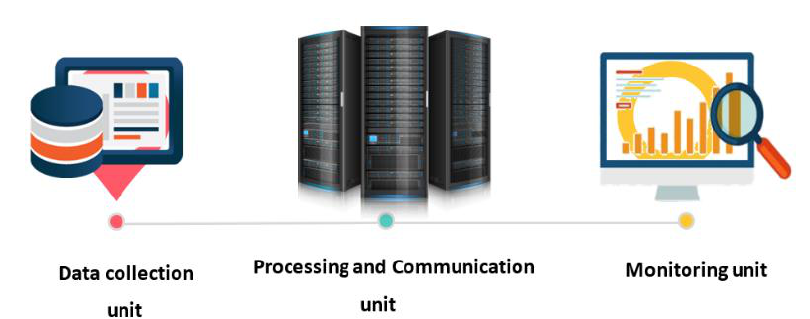
Figure 4. System diagram of the proposed system.